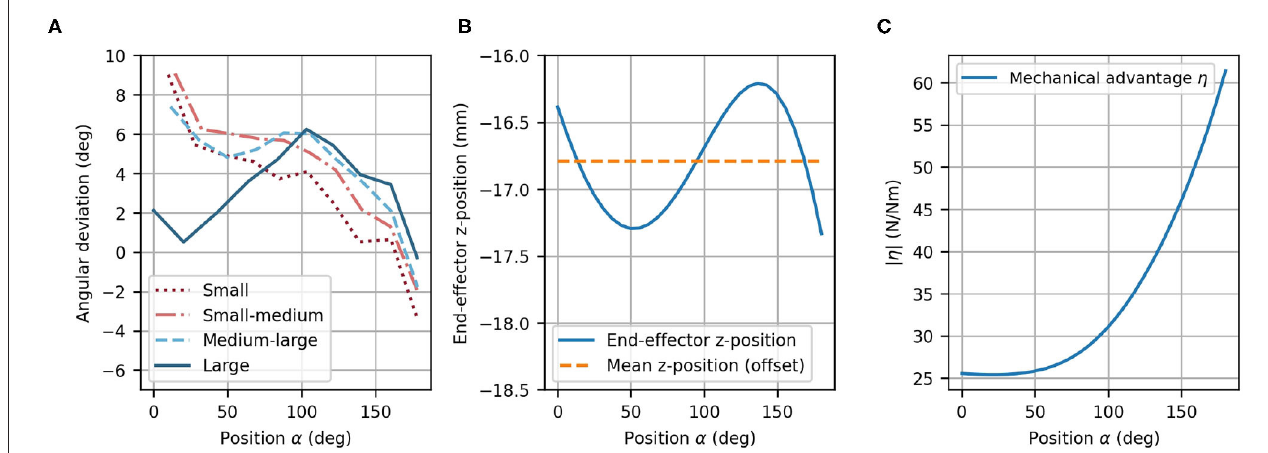
FIGURE 9 | Optimized design parameters. (A) Angular deviation of each optimized finger path with respect to the optimized end-effector path as a function of α . (B) End-effector z -position with offset (dashed line) and variation of the z -position (solid line) as a function of α . Note that the offset (mean of z -position) was taken into account during the mechanical design. (C) The mechanical advantage η increases with α